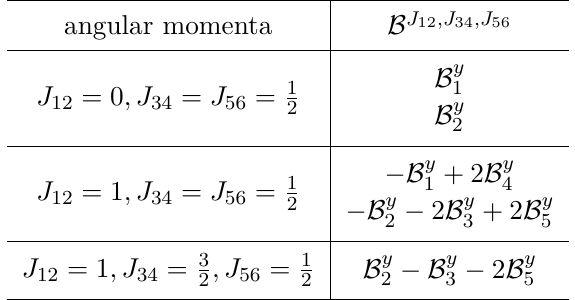
Table 5 . Partial-wave basis of M ( ψ 1 , ψ 2 | ψ 3 , φ 4 | φ 5 , ψ †